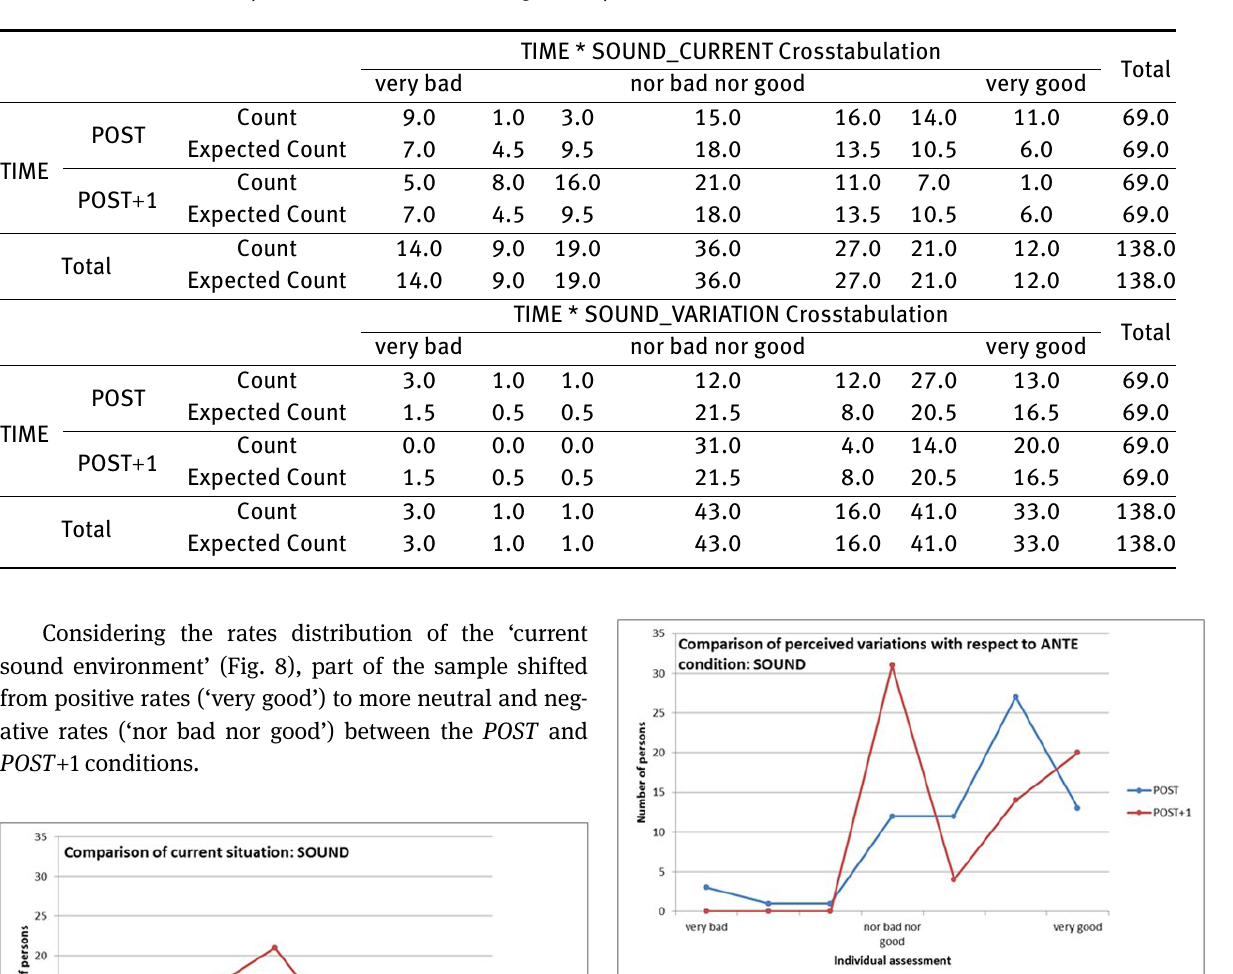
Table 2: The observed and expected variations over the rating scale reported for both Q1 and Q2.